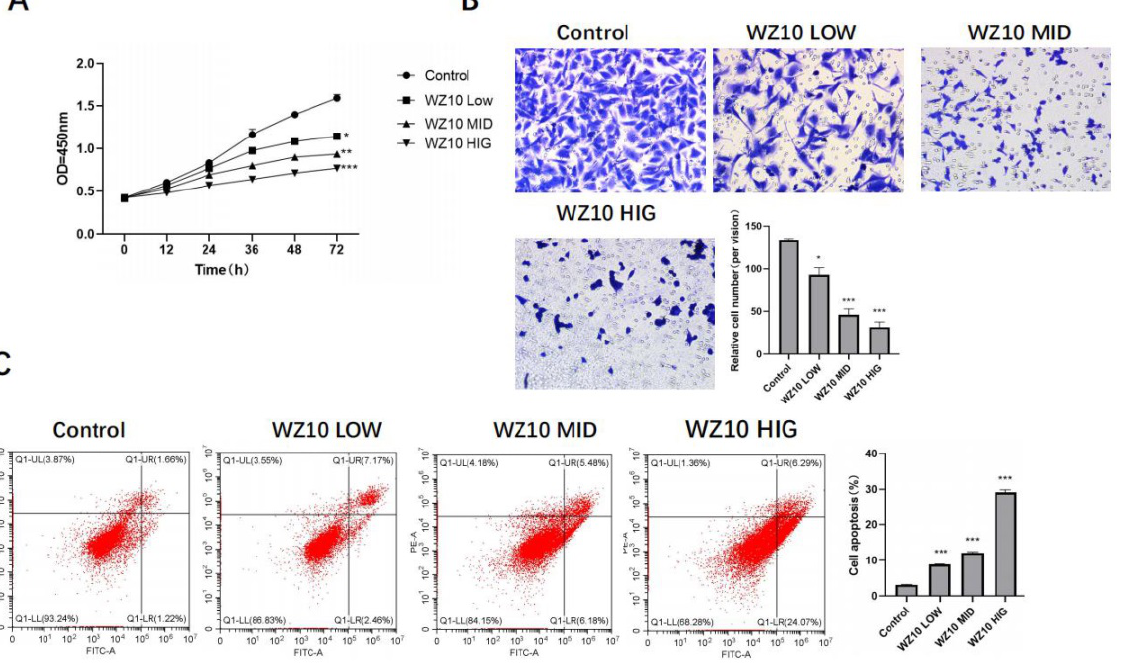
Figure 1. In vitro anti-ovarian cancer activity of WZ10. After treatment with different concentrations of WZ10: ( A ) detection of ovarian cancer cell proliferation activity by MTT; ( B ) detection of ovarian cancer cell invasion activity by Transwell, original image × 50; ( C ) detection of ovarian cancer cell apoptosis level by flow cytometry. Compared with control group, * p < 0.05, ** p < 0.01, *** p < 0.001.